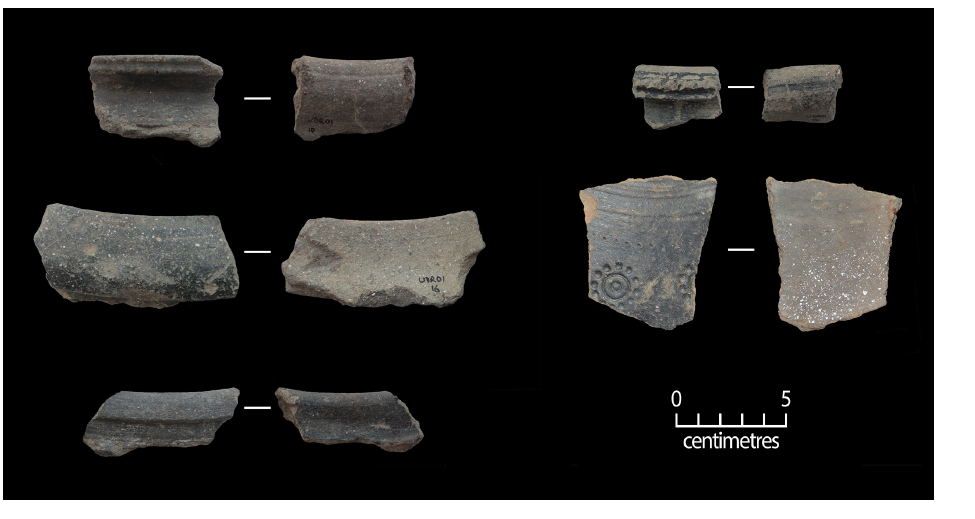
Figure 12: External and internal surfaces of various Class 4 variant 10 potsherds, including one decorated